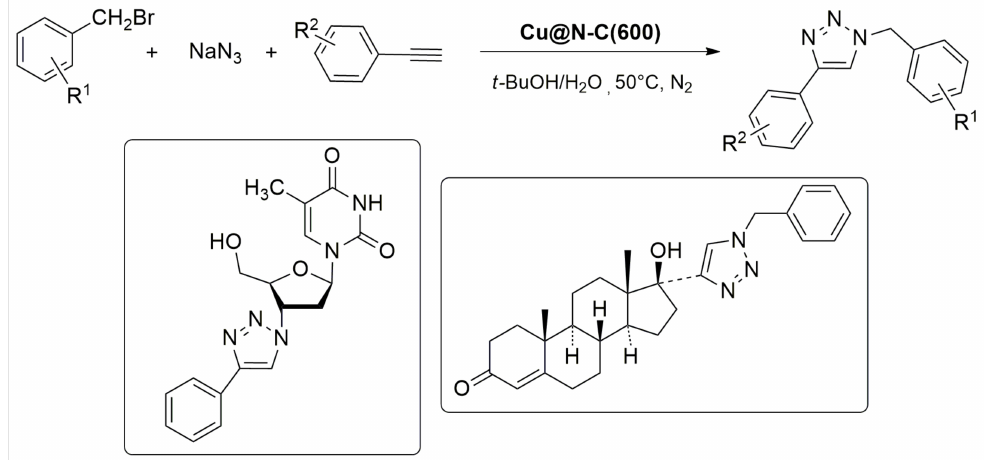
Scheme 16. 3-Dipolar cycloaddition of terminal alkynes, aryl halides, and sodium azide catalyzed